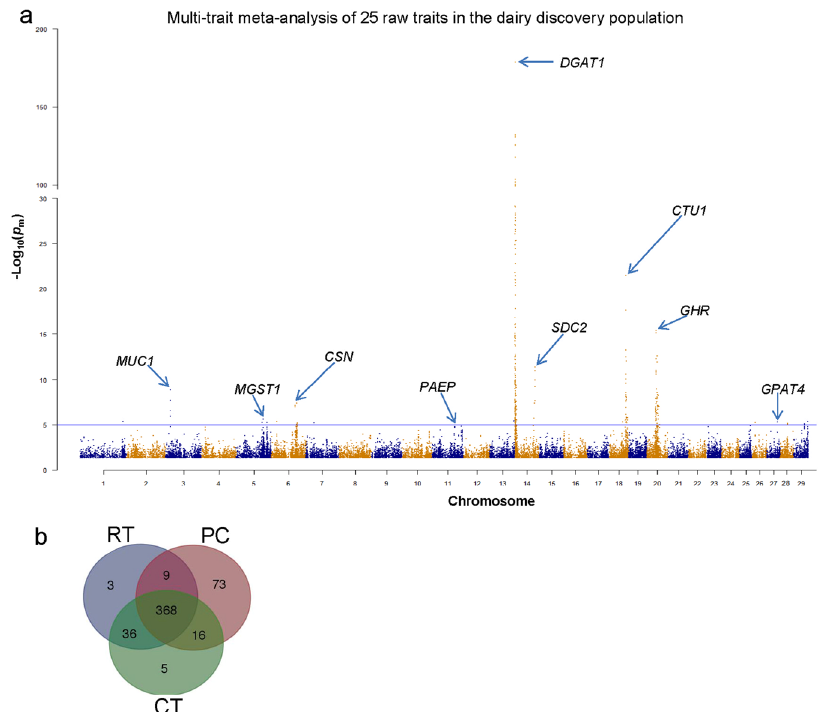
Figure 3. Summary of multi-trait meta-analysis of 25 raw traits (RTs) in the discovery population (dairy bulls). ( a ) Manhattan plot using SNPs with multi-trait meta-analysis p m < 0.05. The horizontal blue line was p m <= 1 × 10 − 5 . Some reported loci affecting milk traits were highlighted. Equivalent Manhattan plots of principal components (PCs) and Cholesky transformed traits (CTs) were shown in Supplementary Figure S3. ( b ) Venn gram showing the overlap of numbers of significant ( p m < 1 × 10 − 5 ) SNPs from multi-trait meta- analysis of RTs, PCs and CTs in the discovery population.